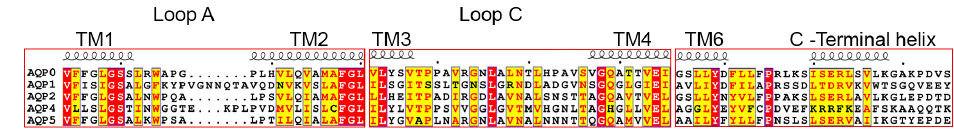
Figure 5. Sequence alignment of water-specific human AQPs . Sequences for human AQP0 (UniProt ID P30301), AQP1 (UniProt ID P29972), AQP2 (UniProt ID P41181), AQP4 (UniProt ID P55087)